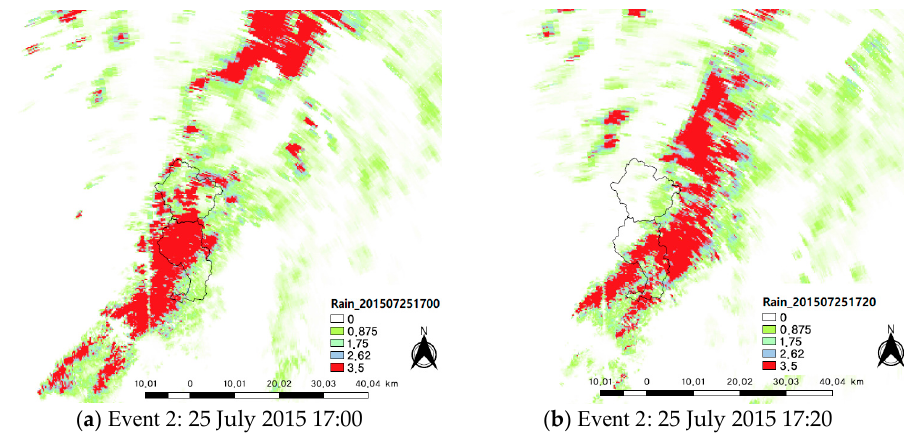
Figure 3. Accumulated rainfall amount (mm/10 min) during ( a ) Event 1 and ( b ) Event 2, observed at KWK radar station, respectively.